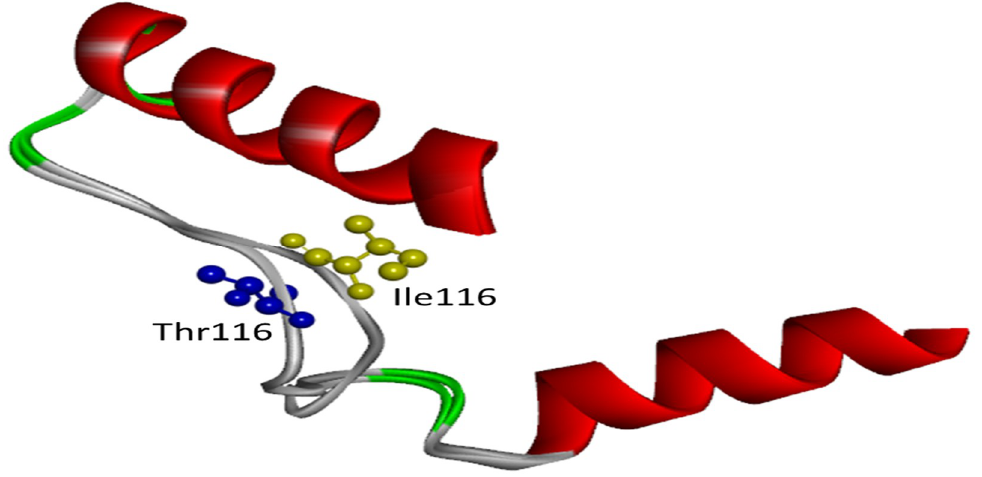
Figure 3. 3D modeling on PSEN1 Thr116Ile mutation, compared to the normal PSEN1. Threonine is labeled with blue while Isoleucine is labeled with yellow. Mutation could disturb significantly the HL-I loop structure.